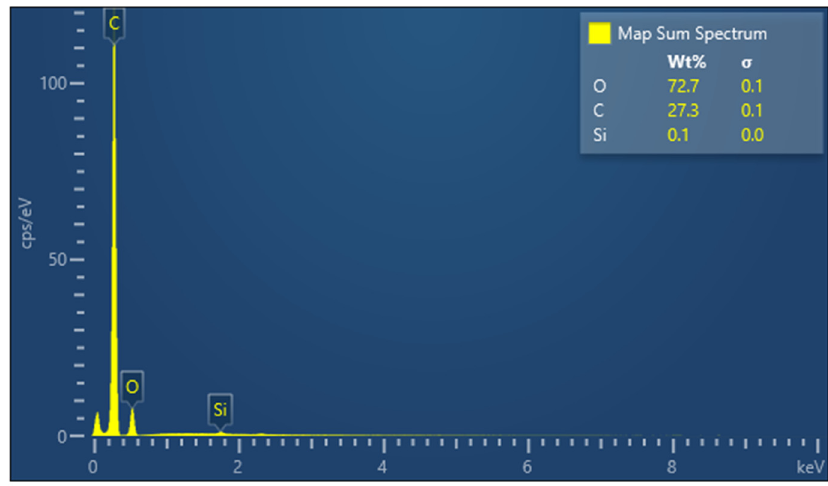
Figure 3. Percentage distribution of the component elements of the resin.